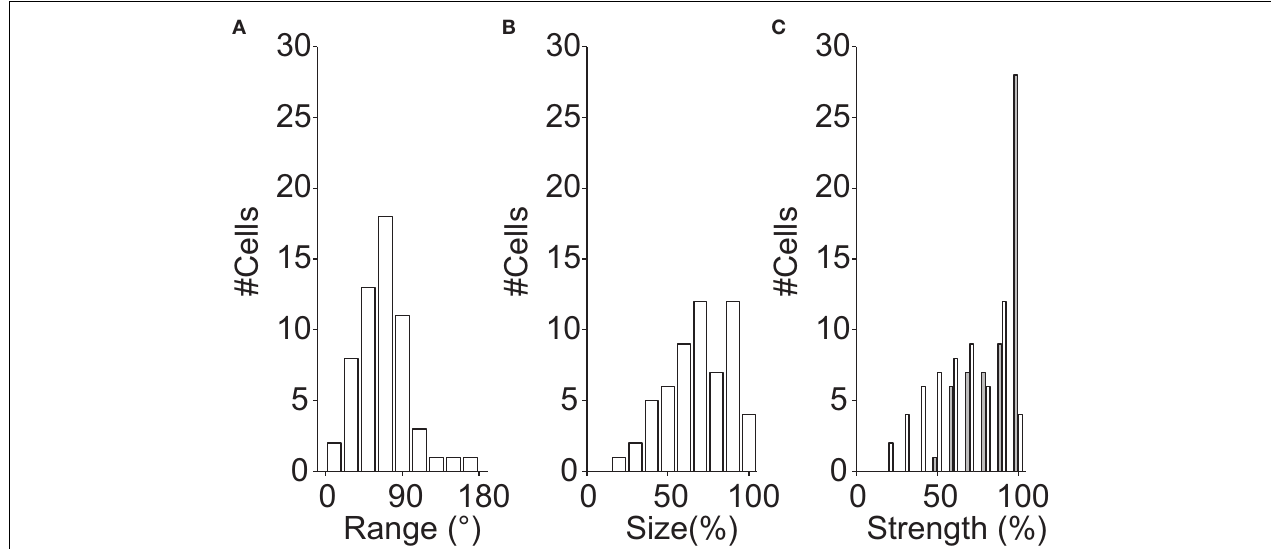
relative tuning strength of the two regions (white bars). A relative strength of 100% represents a neuron in which two regions of the receptive field, with significantly different preferred directions, generated equally large responses. The gray bars represent the relative strength after normalizing by the difference in size [i.e., correcting for the effect shown in (B) ].Together, these data show that the differences in preferred directions were often large (but rarely larger than 90˚), and that the response modulation and the size of the weaker/smaller region is typically 2/3rd of that of the stronger/larger